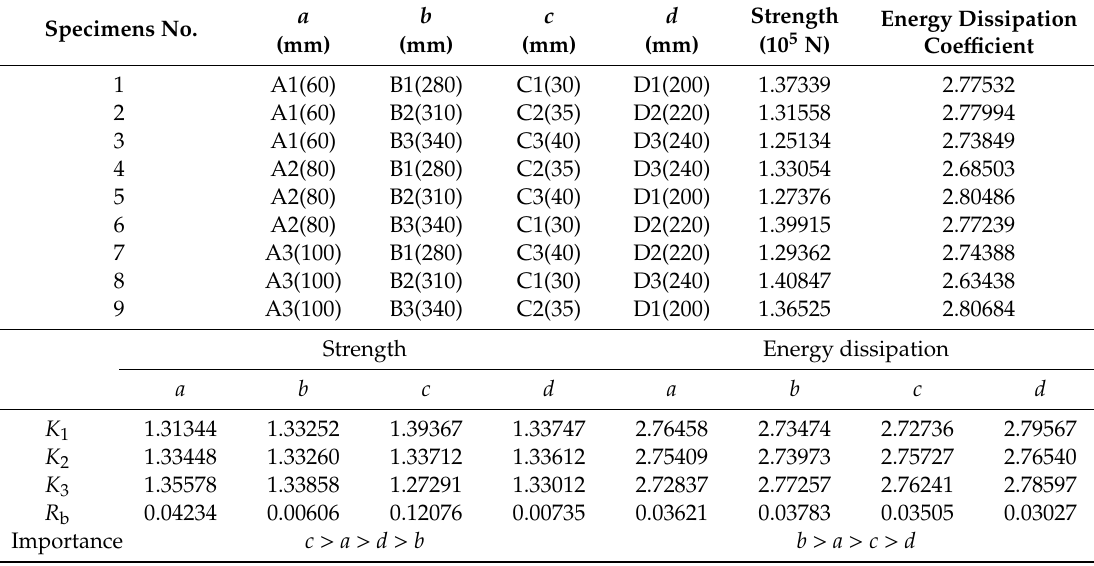
Table 2. Orthogonal design (L 9 3 4